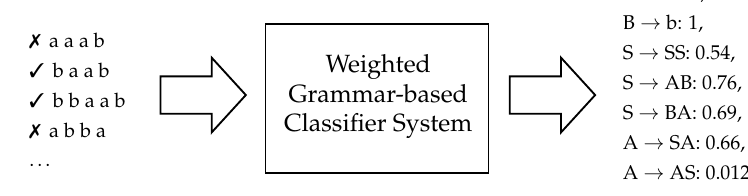
Figure 1. Induction in WGCS model.